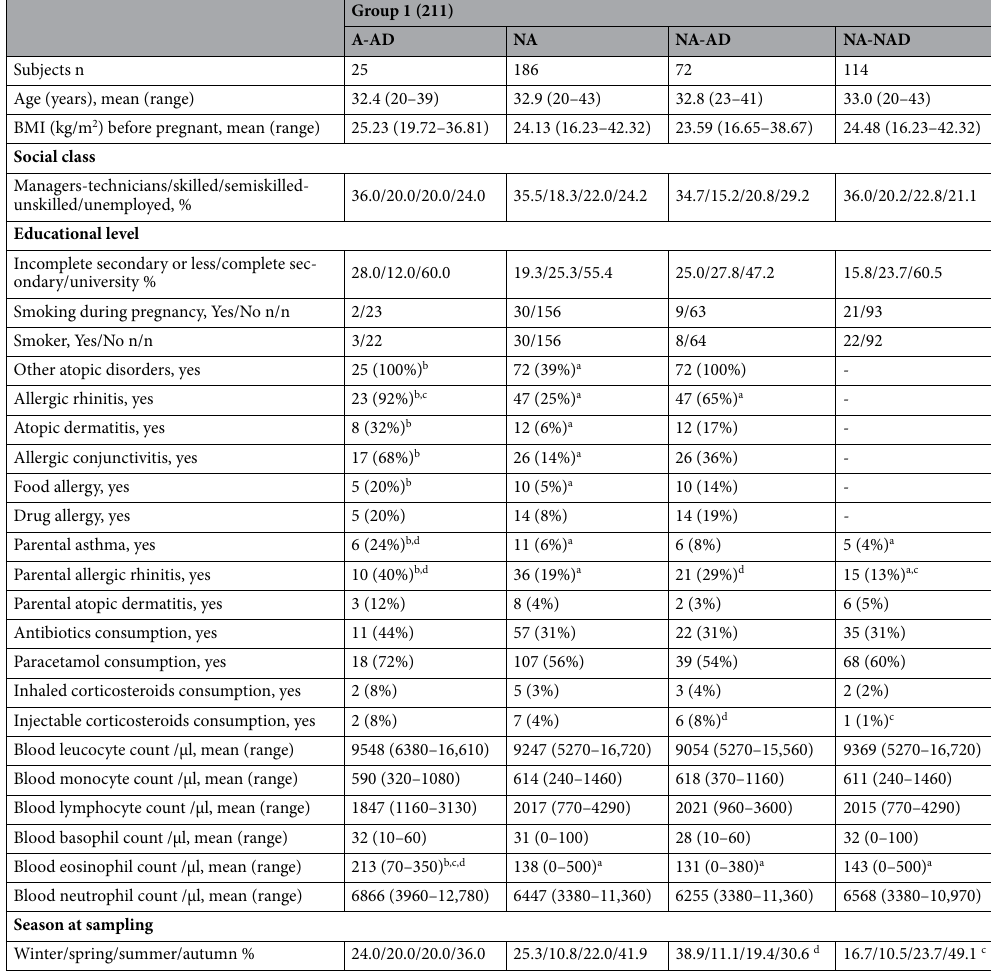
Table 1. Characteristics of the study population: women of childbearing age (Training set—Group 1). A‑AD asthmatics with other coexisting atopic diseases; NA non-asthmatics; NA‑NAD non-asthmatics without atopic diseases; NA‑AD non-asthmatics with other atopic diseases. a Significantly different (p-value < 0.05) from asthmatics with coexisting other atopic diseases (A-AD). b Significantly different (p-value < 0.05) from non- asthmatics (NA). c Significantly different (p-value < 0.05) from non-asthmatics with other atopic diseases (NA- AD). d Significantly different (p-value < 0.05) from non-asthmatic without atopic diseases